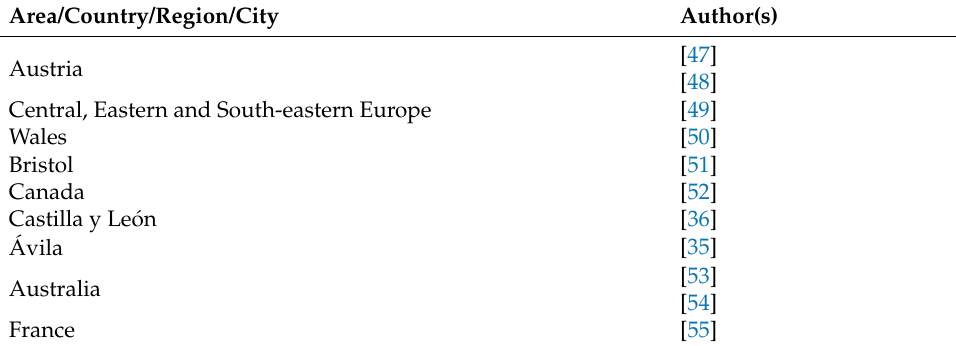
Table 1. Studies on access to banking and financial services.